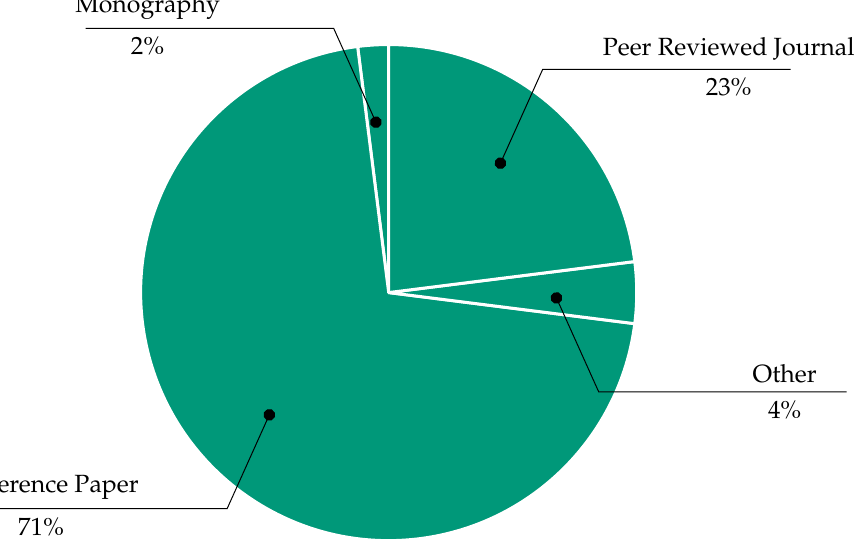
Figure 3. Percentage of each publication in literature